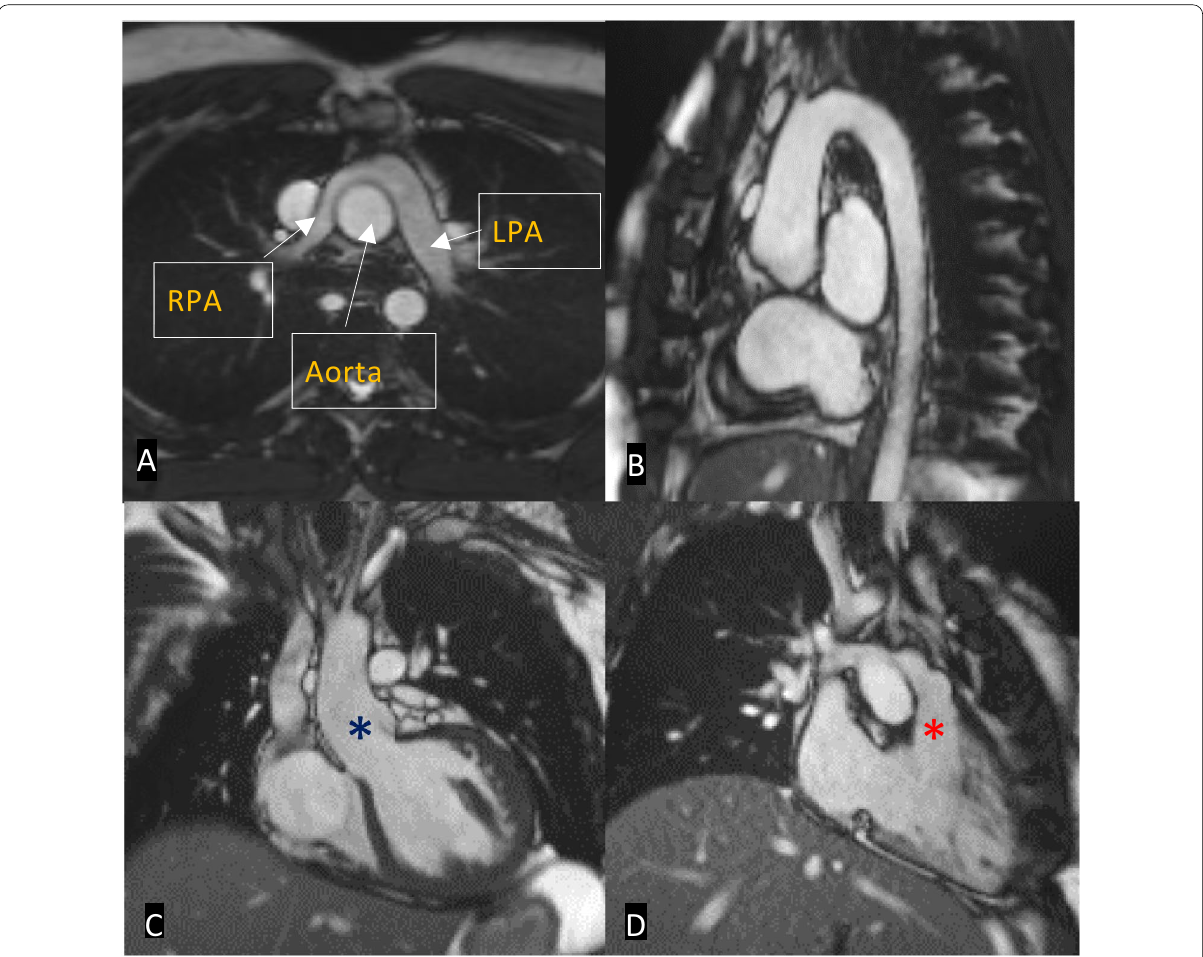
Fig. 13 Still shots of MRI SSFP cine in axial ( A ), sagittal oblique ( B ), coronal left ventricular outflow tract ( C ), and right ventricular inflow and outflow ( D ) views post-arterial switch for D-TGA. A Typical appearances of the Lecompte manoeuvre for the Jatene procedure. The pulmonary arteries bifurcate anterior to the ascending aorta, classically ‘draping’ over it. B Typical appearances of a high aortic arch. C Dilatation of the neo-aortic root (blue asterisk). D Normal appearances of the neo-pulmonary root (red asterisk). RPA: right pulmonary artery; LPA: left pulmonary